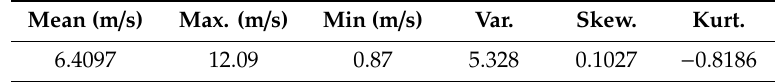
Table 1. Statistics information of data.